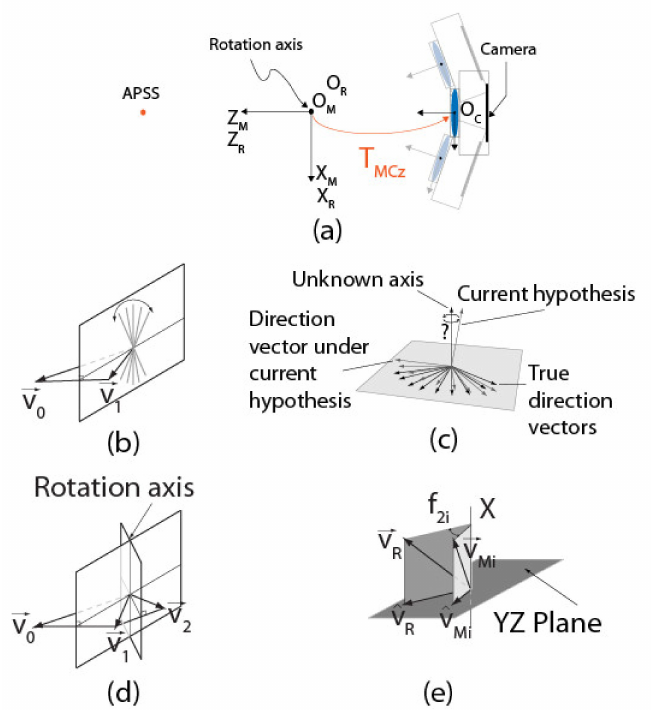
Figure 17. Procedure for calibrating E MC . The camera observes the APSS while being positioned at different orientations caused by rotations around the Y -axis (longitudinal axis). The observation of the speckle pattern at each position allows the pose of the camera to be estimated with respect to the orientation device ( T MCz for this 2D example). The same procedure is applied for the X -axis (latitudinal axis) ( a ). Any axis in a plane can explain the rotation from V 1 to V 2 ( b ). Unknown axis and current hypothesis in the non-linear optimization algorithm ( c ). Change in the orientation of a direction vector ( d ). Estimation of the rotation angle by projecting the direction vectors on the plane perpendicular to the rotation axis ( e ).